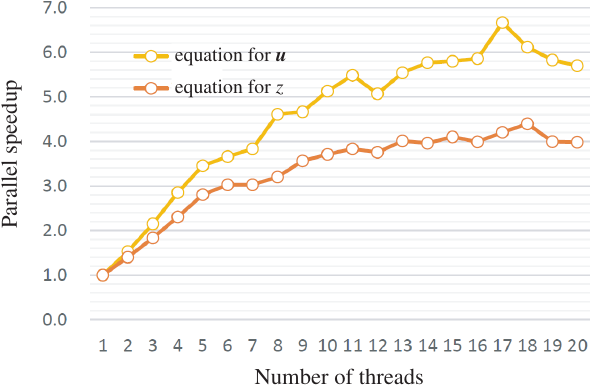
Figure 12. Parallel acceleration for the 101 × 101 × 102